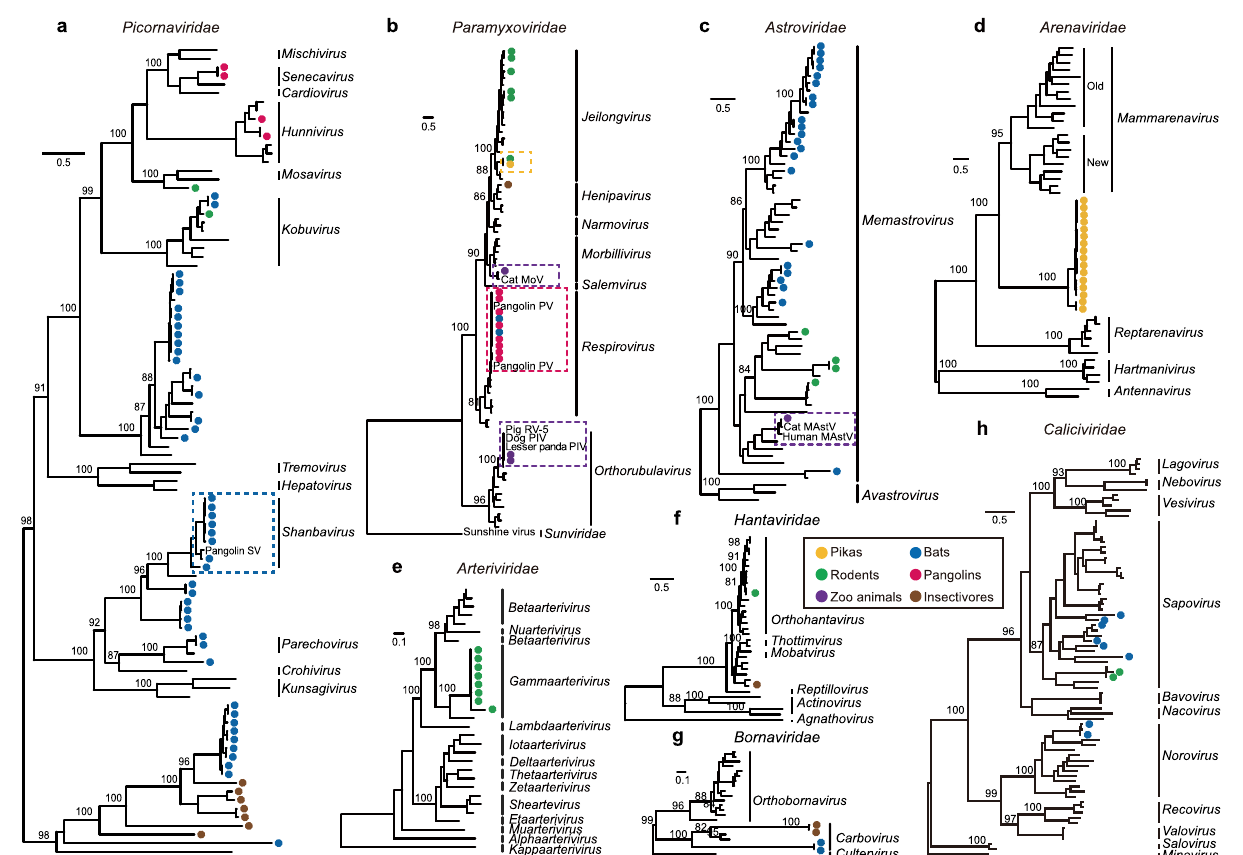
b Paramyxoviridae , c Astroviridae , and h Caliciviridae based on the amino acid sequencesoftheLargeprotein,thecapsidproteinprecursorandVP1,respectively. Numbers (>80) above branches are percentage bootstrap values for the major nodes. The scale bars depict the number of amino acid substitutions per site. Detailed trees are showed in Supplementary Fig.